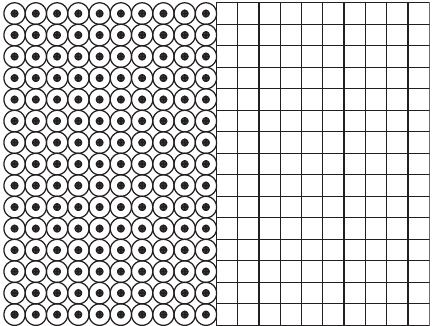
Figure 3: Schematic diagram of SPH particles coupling with FEM meshes.